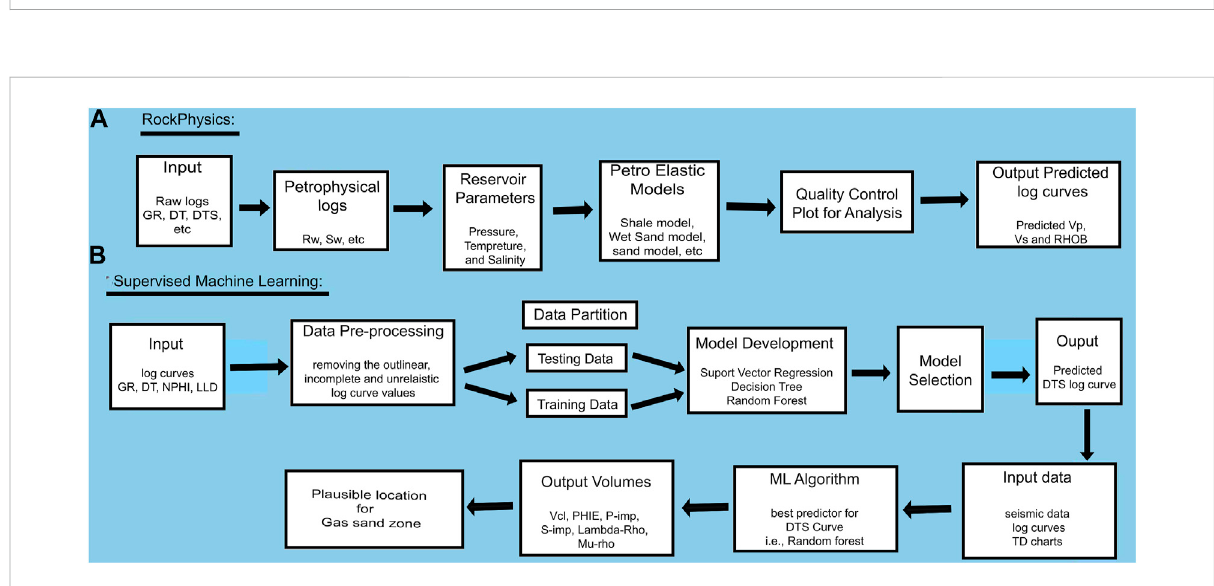
FIGURE 2 (A) Steps for conventional rock physics modeling work fl ow, and (B) SML procedure for prediction of DTS along with other elastic, and petrophysical